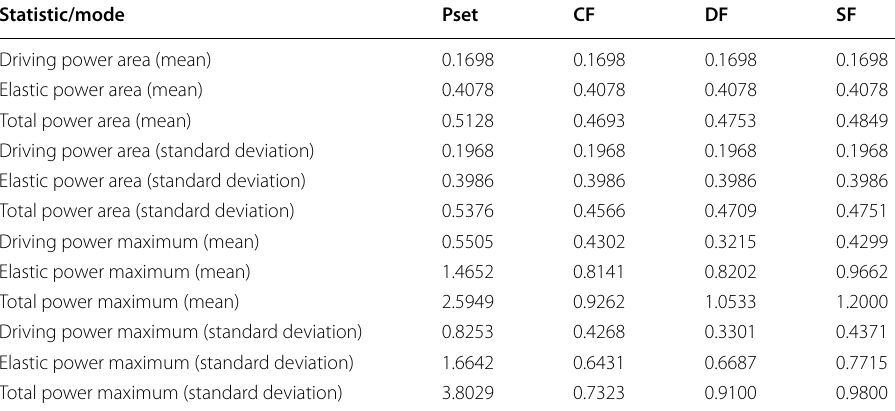
Table 1 Means and standard deviations of areas and maximum power values that exceed the elastic pressure threshold of 20 cmH O for the 5000 virtual ARDS patient population using the four 2 modes (flow profiles) of ventilation